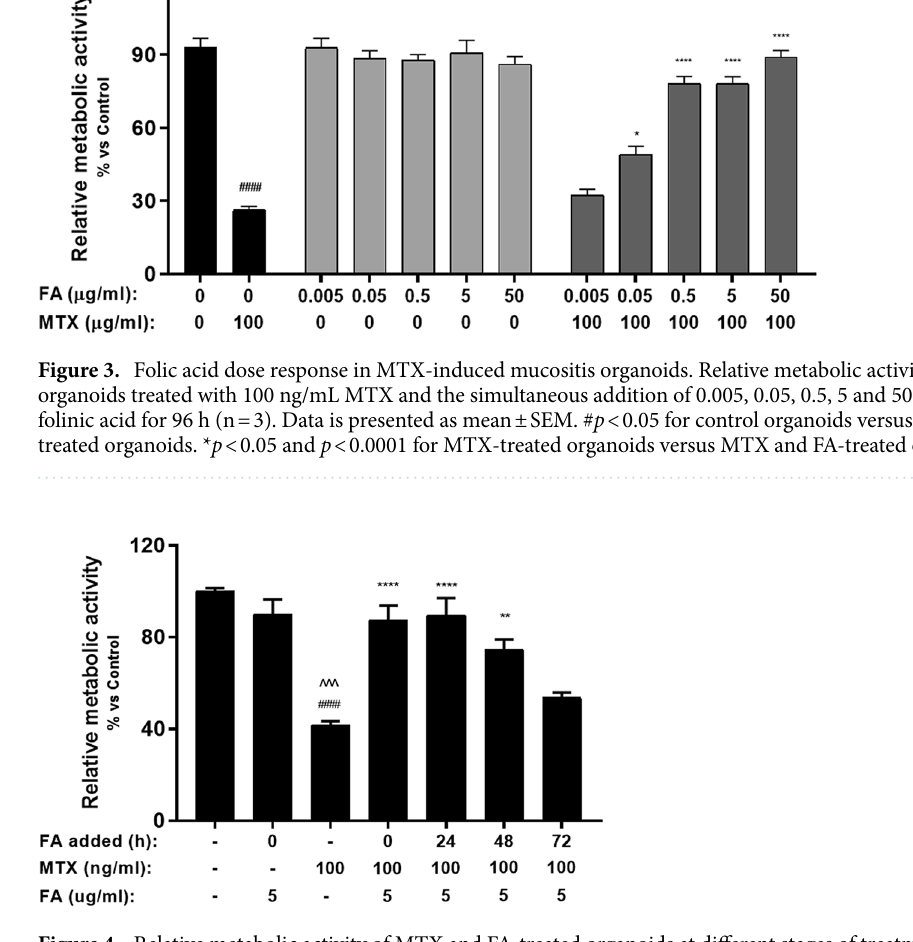
Figure 4. Relative metabolic activity of MTX and FA-treated organoids at different stages of treatment. MTX- treated organoids were supplemented with FA at different time points (0, 24, 48 and 72 h) with 5 µg/mL FA (n = 4). Metabolic activity was measured by WST-1 assay. All data are presented as Mean ± SEM. #### p < 0.0001 represents the significant differences observed between untreated organoids and MTX-treated organoids. ^^^ p < 0.001 represents the significant differences between FA-treated organoids and MTX-treated organoids. ** p < 0.01 and **** p < 0.0001 represent the differences observed between MTX-treated organoids and MTX/ FA-treated